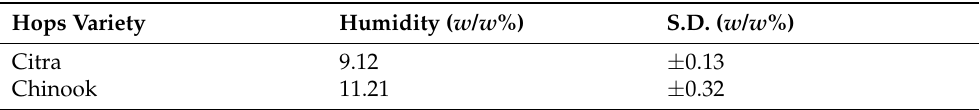
Table 2. Results of the humidity level analysis performed on the pellet samples in triplicate. Hops